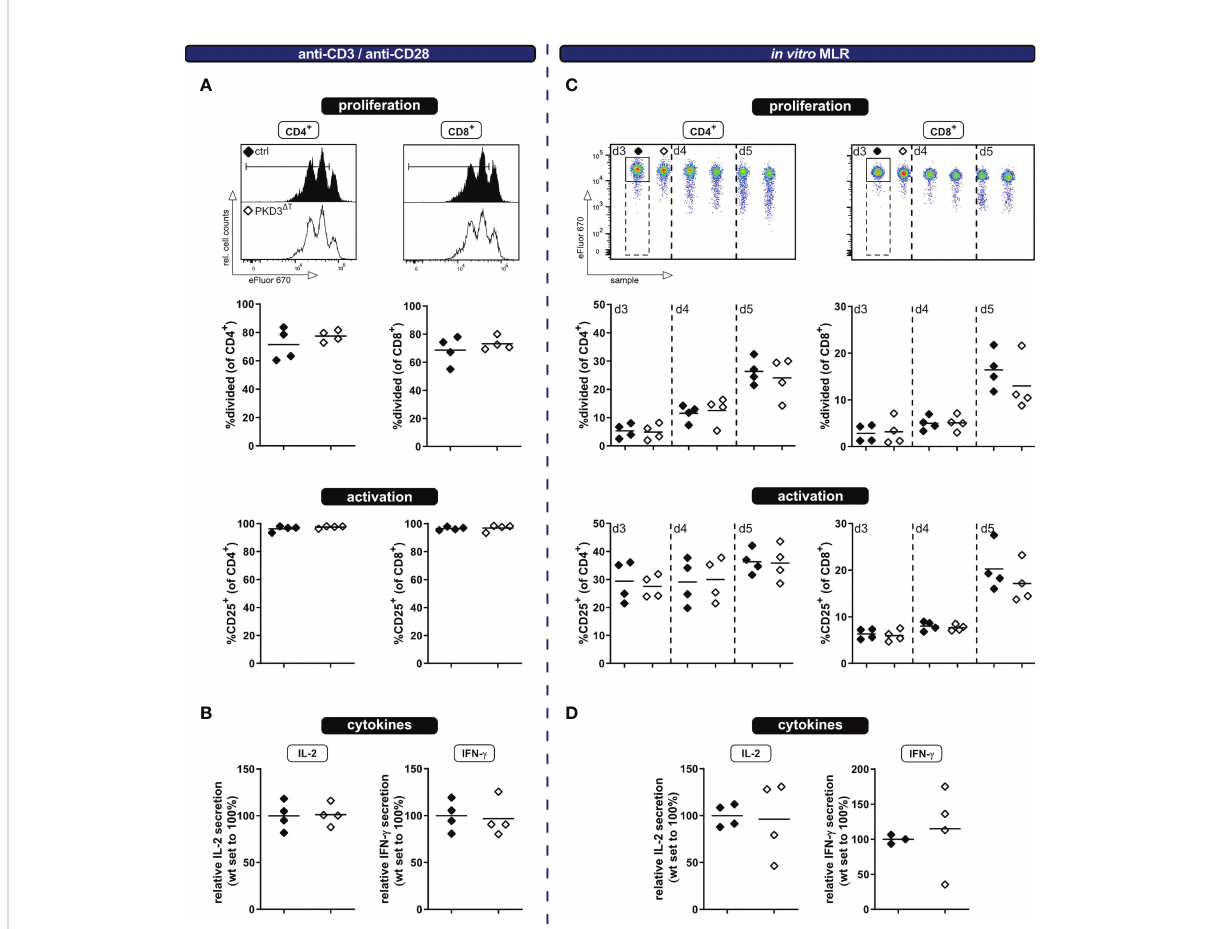
FIGURE 2 T cells from PKD3 D T mice show a similar response to wild type T cells upon polyclonal stimulation in vitro. Ex vivo MACS-sorted CD3 + T cells from PKD3 D T mice ( ⬦ ) and respective controls ( ♦ ) were labelled with the proliferation dye eFluor670 and subsequently stimulated with platebound anti-CD3 and soluble anti-CD28 antibodies (left side) or in a mixed lymphocyte reaction with allogeneic splenocytes (right side). (A + C) Activation/proliferation was analyzed by fl ow cytometry after 3 or 3 – 5 days, respectively. Representative FACS histograms of the proliferation dye together with summarizing graphs are shown. (B + D) Secretion of IL-2 and IFN- g (see Figure 1D) was determined by luminex from the cell culture supernatant. (n = 4, from 2 independent